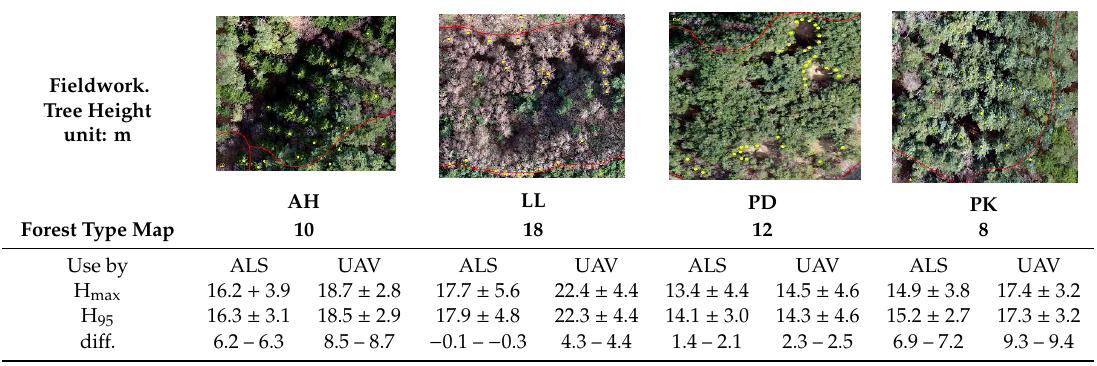
Table 11. Comparison of tree heights according to the forest type map and fieldwork (unit: m).